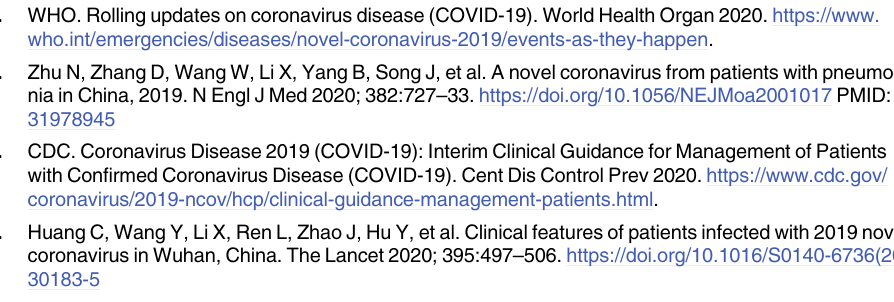
betaine in the reaction buffer. The figure shows the electrophoretic profile of the